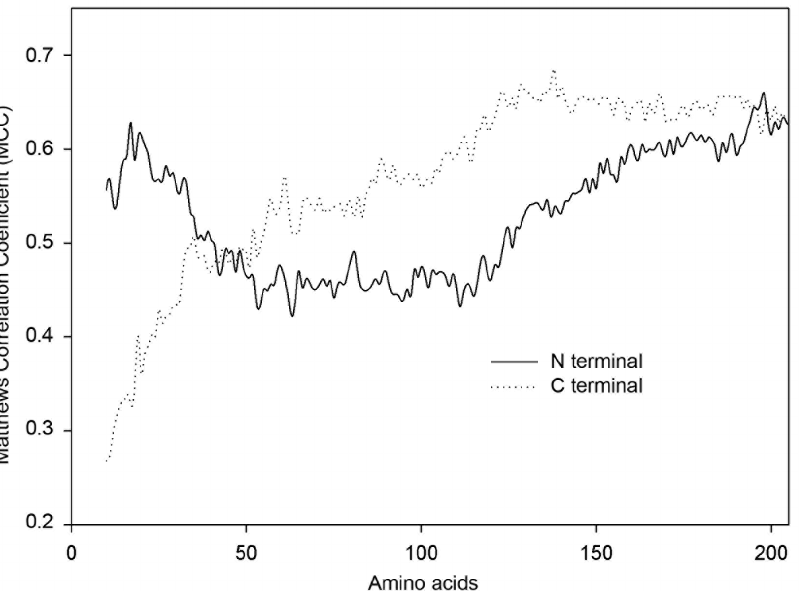
Figure 3. Prediction performance of Presep with different protein lengths. The x axis represents the selected residues at N or C terminal that were used to predict the secretion propensity in the dataset. The y axis represents the prediction performance, which was evaluated by Matthews correlation coefficient (MCC). A Type I PseAAC coding scheme was used with a weight factor (w) of 0.05 and a lambda parameter ( l ) of 19. Results are based on the Secreprot dataset with 20-fold cross